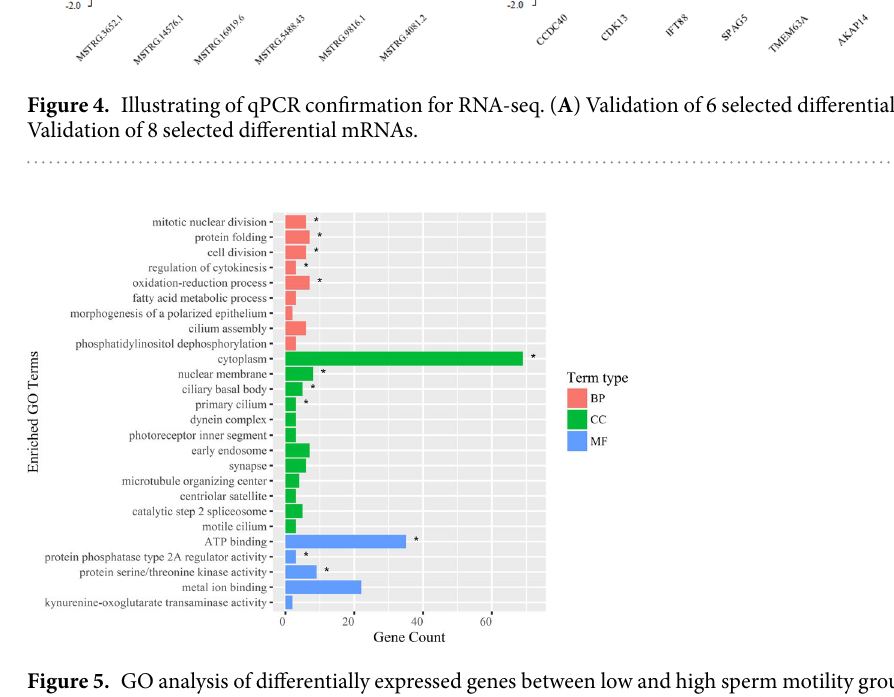
Figure 5. GO analysis of differentially expressed genes between low and high sperm motility groups. BP: biological process; CC: cellular component; MF: molecular function. The marked “ * ” means significantly enriched GO